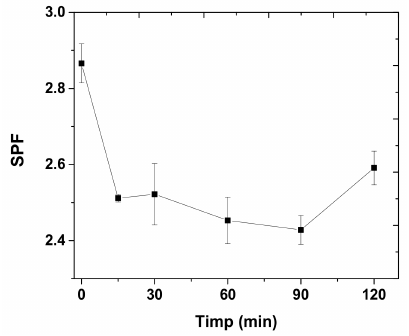
Figure 9. SPF of apple extract as a function of irradiation time.